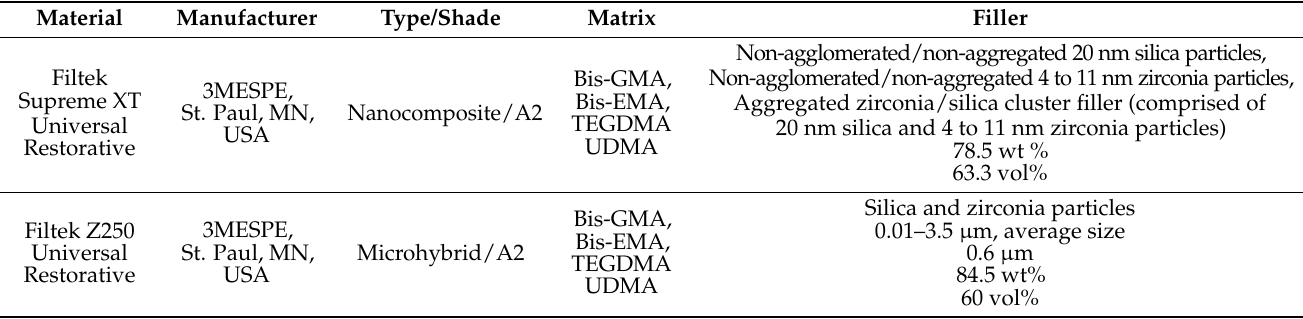
Table 2. Structure of the two